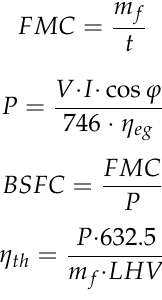
Figure 5. Schematic illustration of the experimental flow and data recording procedure.